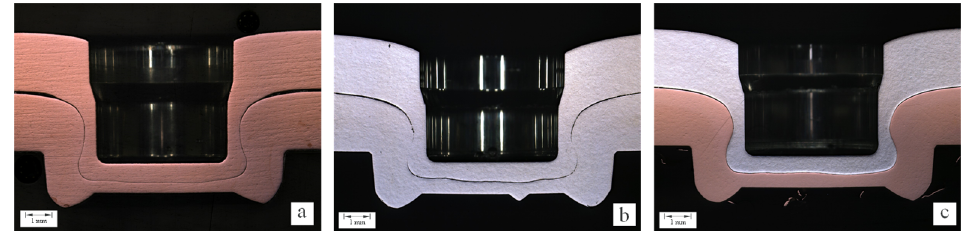
Figure 1. Cross-section of clinched joints: ( a ) Cu-Cu, ( b ) Al-Al, and ( c )